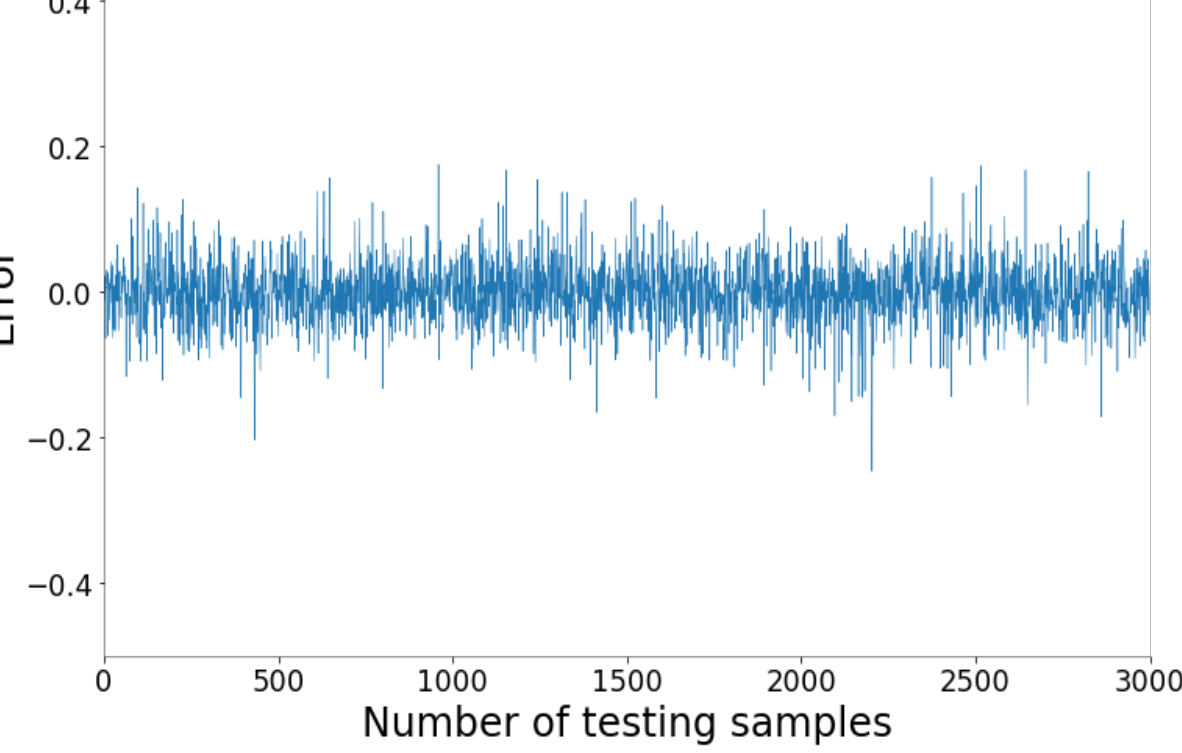
Figure 5. The error diagram of NOx emission concentration model.